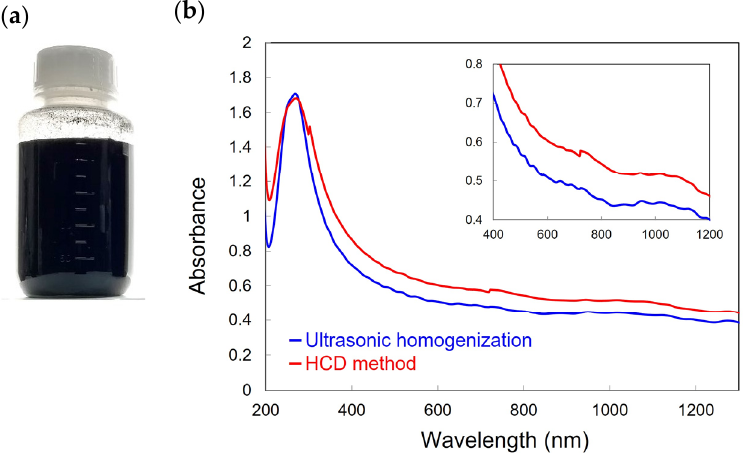
Figure 1. ( a ) Photograph of SWCNT solution dispersed via the HCD method and ( b ) optical absorp- tion spectra of SWCNT solutions after ultracentrifugation. The inset shows enlarged spectra at the visible and NIR range (400–1200